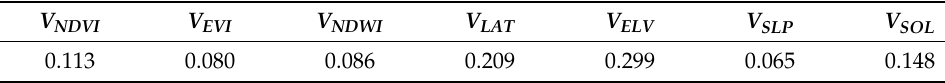
Table 1. The average variable importance scores of the reconstructed days.